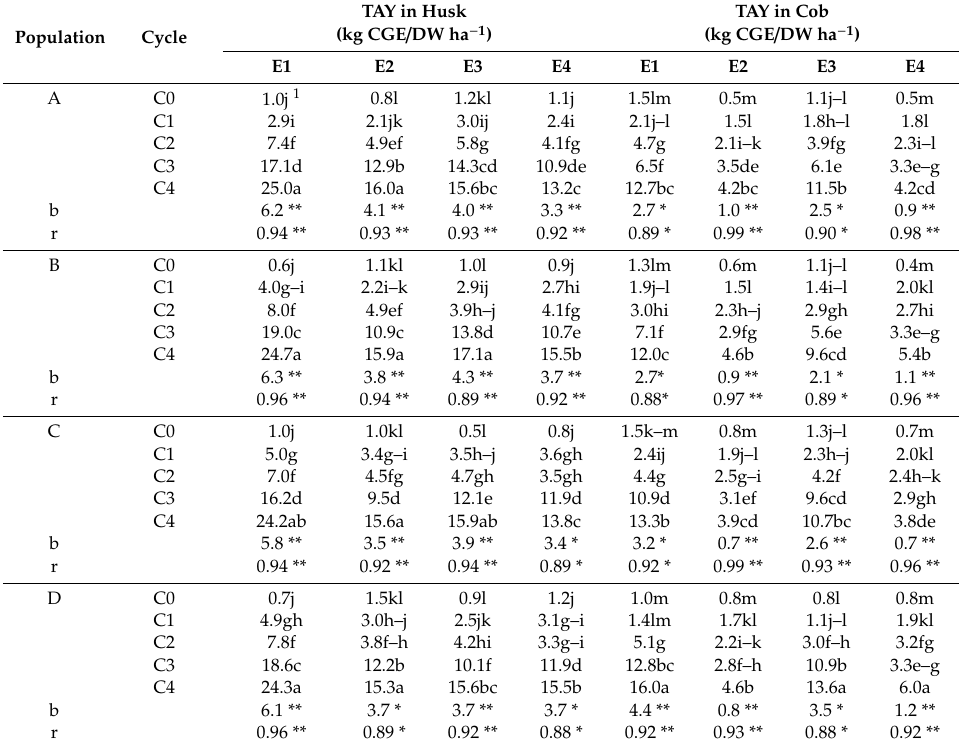
Table A4. Means for total anthocyanin yield (TAY) in husk and cob of (A–E) five populations and (C0–C4) five cycles evaluated in four